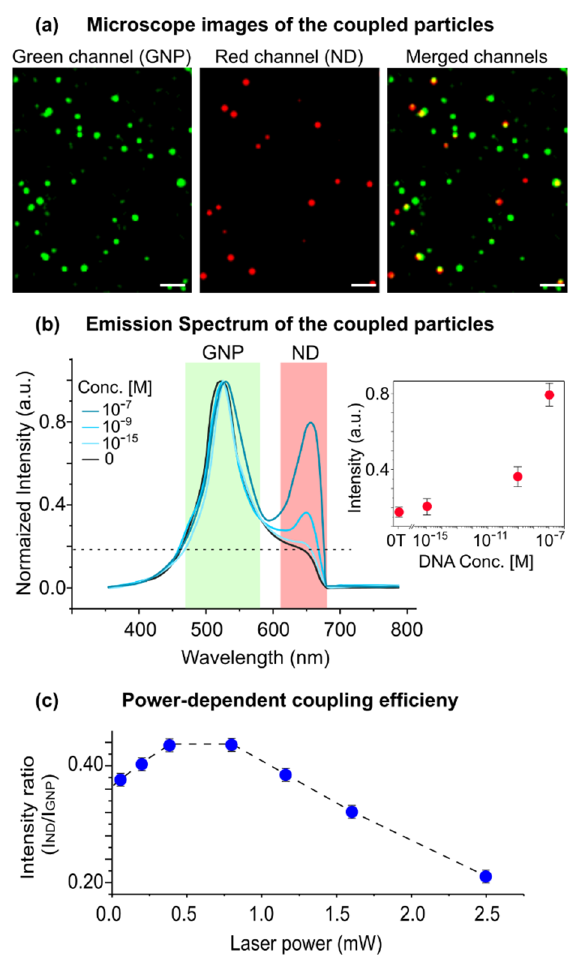
Figure 3. Optical properties of the coupled GNP–ND system. ( a ) Far-field optical images of the coupled system under multiphoton excitation ( λ excitation = 1020 nm laser power ~1 mW). Green and red channels correspond to emission in the 480–580 nm (GNPs) and 620–680 nm (nanodiamonds) ranges, respectively. A total of 95% of the emission centers in the red channels are colocalized with the emission centers in the green channel. Scale bars, 4 µm. ( b ) The spectrum of the coupled particles. The intensity of the red channel (nanodiamond emission) increases by the number of coupled particles. The number of coupled particles can be controlled by the concentration of the target DNA during hybridization (inset). 0 T indicates 0 M concentration of the target DNA. ( c ) The ratio of the emission intensity of the nanodiamonds to the gold nanoparticles, defined as coupling efficiency, exhibits a non-linear dependence on the laser power, with a maximum at ~0.7 mW.